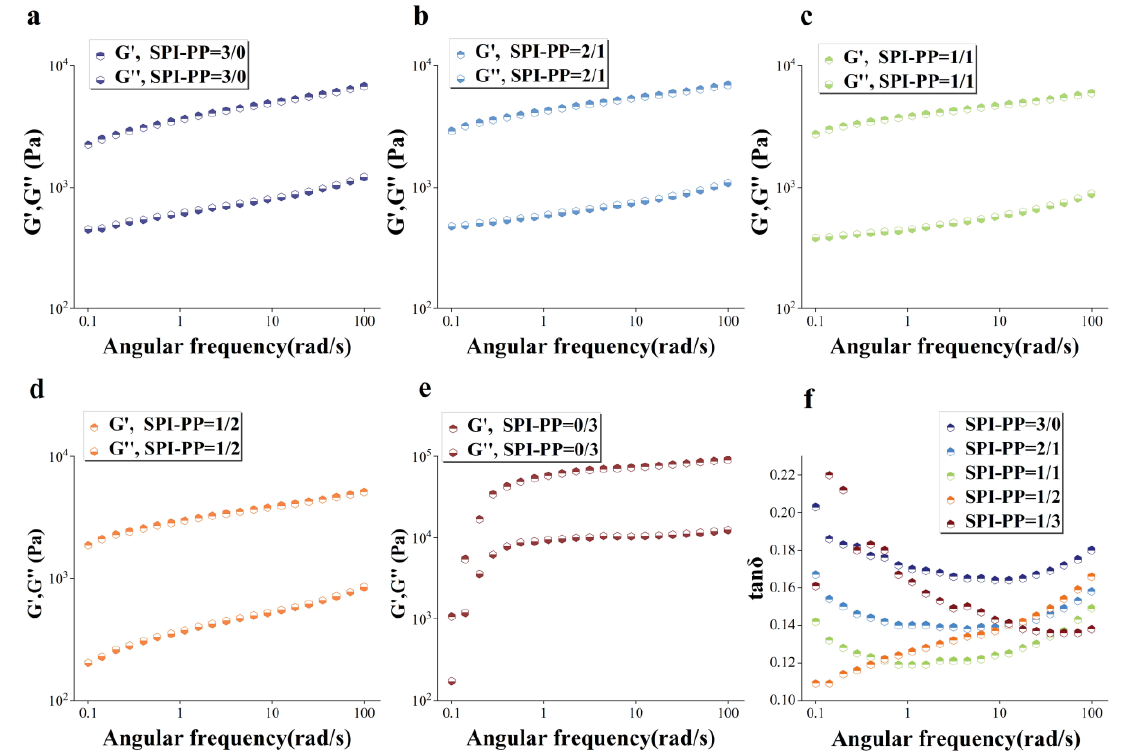
Figure 4. Dynamic rheological diagrams of composite gels. ( a ), G′, G″( a – e ) of SPI-PP = 3/0; ( b ) SPI- PP = 2/1; ( c ) SPI-PP = 1/1; ( d ) SPI-PP = 1/2; ( e ) SPI-PP = 0/3; and ( f ) tanδ of composite gels.